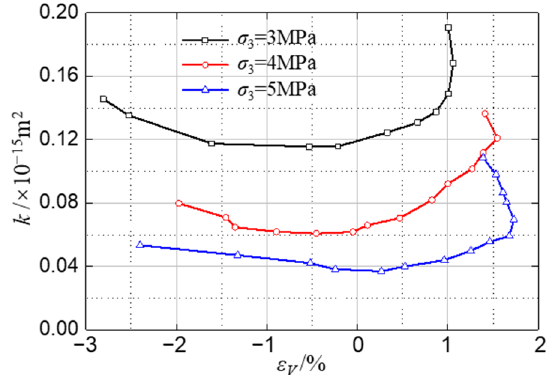
Figure 11. Volumetric strain versus gas permeability curves under different confining pressures.